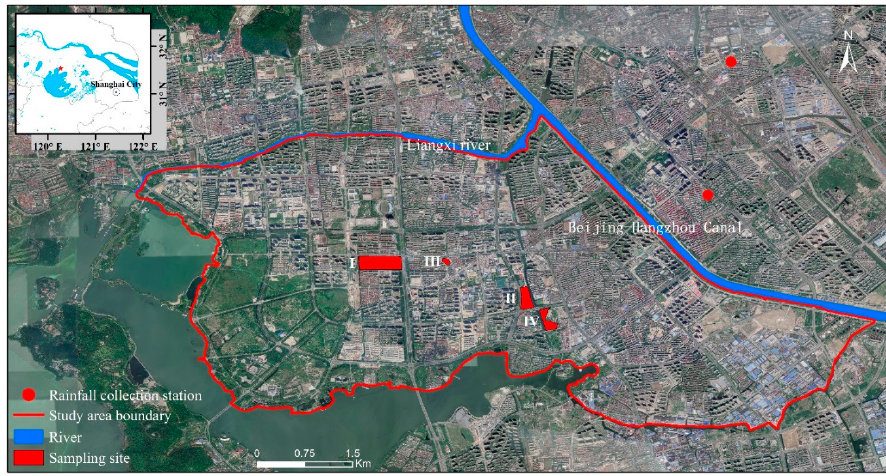
Figure 1. Location of study area and four sampling sites. I–IV indicates the four sub-catchments that dominated by residence, park, commercial area, and greenbelt,